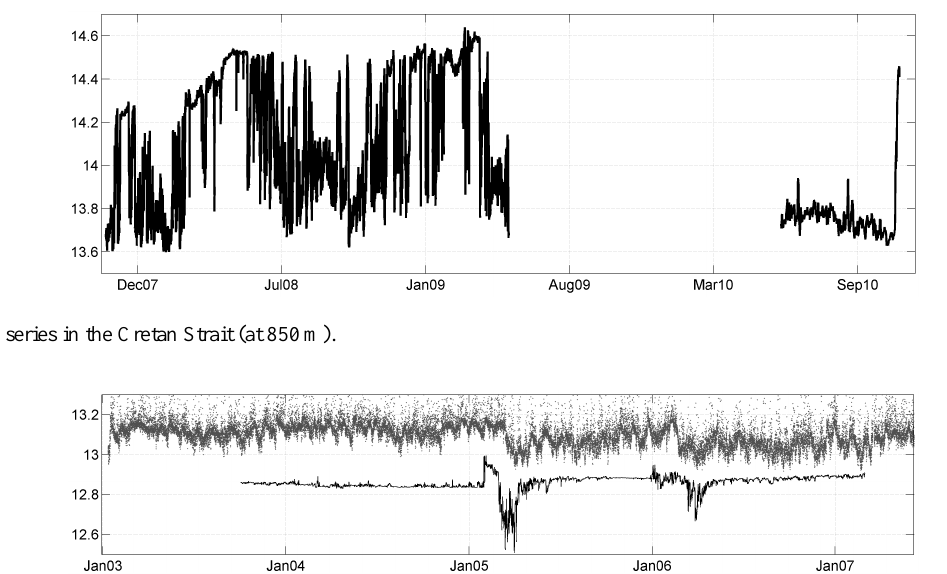
Garc ´ ıa-Lafuente et al. (2007) found a signature of the DWF events in the MOW (Fig. 15). At Gibraltar (CAS